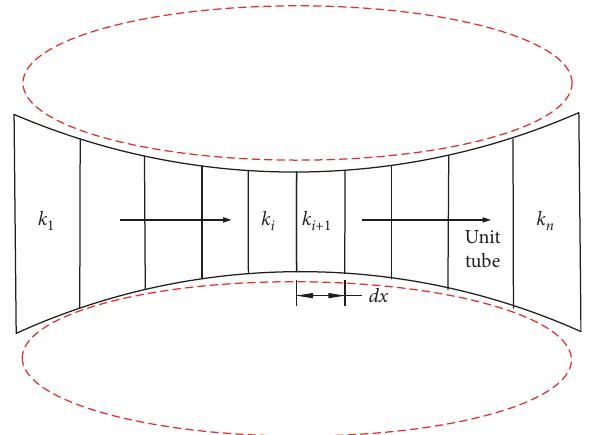
Figure 6: Distribution of unit tube in one period. The pore in one period is divided into countless pore units with the same width dx